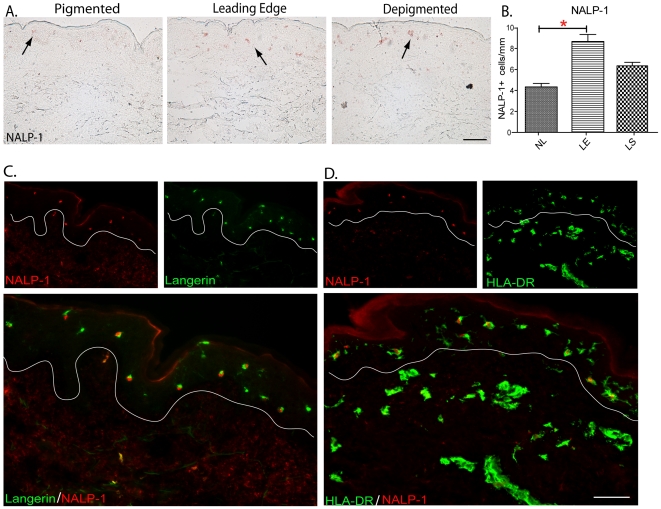
NALP-1 positive Langerhans cells are found in lesional vitiligo
skin.Immunohistochemical staining of NALP-1 on vitiligo biopsies and double
staining of NALP-1 with CD207 and HLA-DR on lesional skin. (A)
Immunohistochemical staining shows higher numbers of NALP-1 positive
inflammasomes in leading edge vitiligo skin biopsies when compared to
normal skin from healthy patients. (B) Quantification of NALP-1 positive
cells per mm of skin (p<0.05) (C) NALP-1 colocalized with
Langerin/CD207, a Langerhans cell marker, in lesional vitiligo skin. (D)
NALP-1 colocalized with HLA-DR, a marker for activated dendritic cells,
in lesional vitiligo skin. In 3C&D, single-stained controls are
above the merged image, white line denotes dermal-epidermal junction.
Fluorescent signals of NALP-1 appear as red, whereas Langerin and HLA-DR
signals appear as green. Areas of colocalization appear as orange.
Bar = 100 mm, applies to both A, C&D.